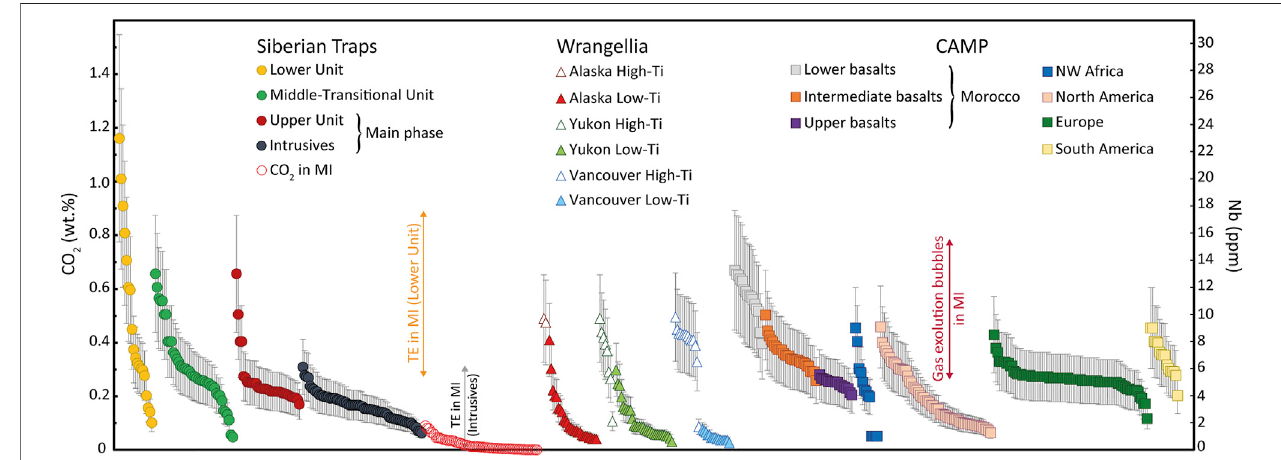
FIGURE2| InitialmaximumCO 2 budgetsobtainedfromNbwhole-rockconcentrationsofmagmasfortheSiberianTraps(circles),theWrangellia(triangles)andthe CAMP (squares). Following Rosenthal et al. (2015), we assumed CO 2 /Nb = 505 ± 168, which corresponds to mantle source CO 2 of 75 ± 25 ppm. Data are fi ltered for MgO > 7wt%.Maximumand minimumMgOcontentsare22.9 – 7.1 wt%(average 10.2 wt%) fortheSiberianTraps, 17.5 – 7.1 wt%(average9.8 wt%)fortheWrangellia, and 16.6 – 7.0 wt% (average 8.7 wt%) for the CAMP. Data are plotted in ranked order. Siberian Traps: data from GEOROC Database (http://georoc.mpch-mainz. gwdg.de/); Hawkesworth et al. (1995); Sobolev et al. (2009, 2011); Sibik et al. (2015); Callegaro et al. (2021). Wrangellia: data from Greene et al. (2009a), Greene et al. (2009b), Greene et al. (2010). CAMP: data from De Min et al. (2003); Jourdan et al. (2003); Deckart et al. (2005); Verati et al. (2005); Merle et al. (2011, 2014); Callegaro etal.(2013,2014b);Bertrandetal.(2014);Marzolietal.(2019).Alldataarereportedinthe SupplementaryAppendixTable .CO 2 concentrationsmeasuredfrom melt inclusions (MI) for the Siberian Traps (Black et al., 2014; Sibik et al., 2015) are reported for comparison (open circles). Yellow and grey arrows represent CO 2 estimates obtained from trace element (TE) concentrations in melt inclusions following the same approach as whole-rock data. CO 2 concentrations obtained from MIoftheGudchikhinskyFormation(yellowcolour;LowerUnit)andofintrusivesofthemainphaseoftheSiberianTraps(greycolour;Sibiketal.,2015)areca.0.3 –